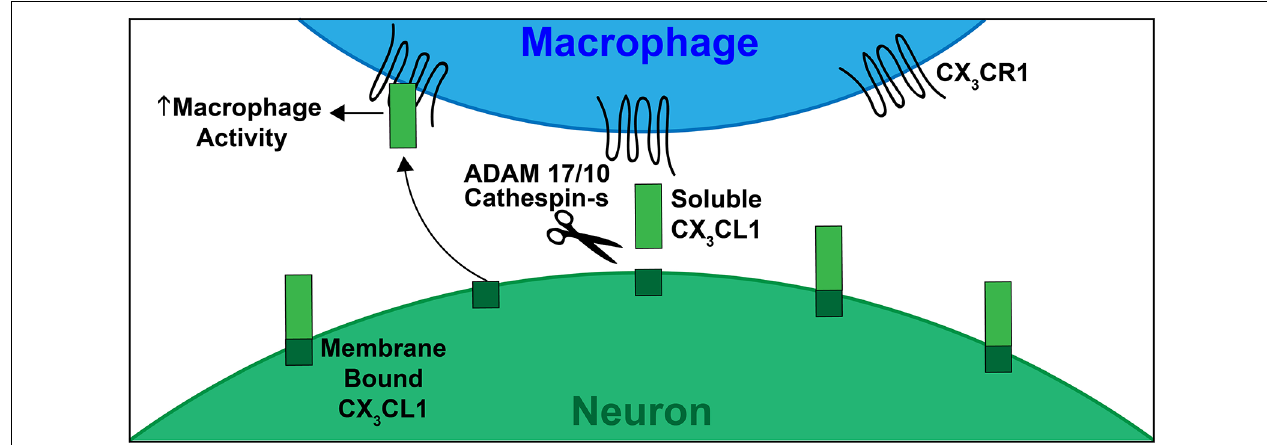
FIGURE 2 | Schematic depicting CX 3 CL1-CX 3 CR1 signaling. CX 3 CL1 of FKN (ligand) is constitutively expressed by neurons in the CNS, PNS and by SGNs and IHCs in the mature cochlea. The CX 3 CR1 (receptor) is present on immune cells, including monocytes, macrophages, and microglia. In response to damage, CX 3 CL1 is proteolytically cleaved from the extracellular side of the neuronal cell membrane via ADAMs 17/10 or Cathespin-s. This cleavage produces the soluble form of